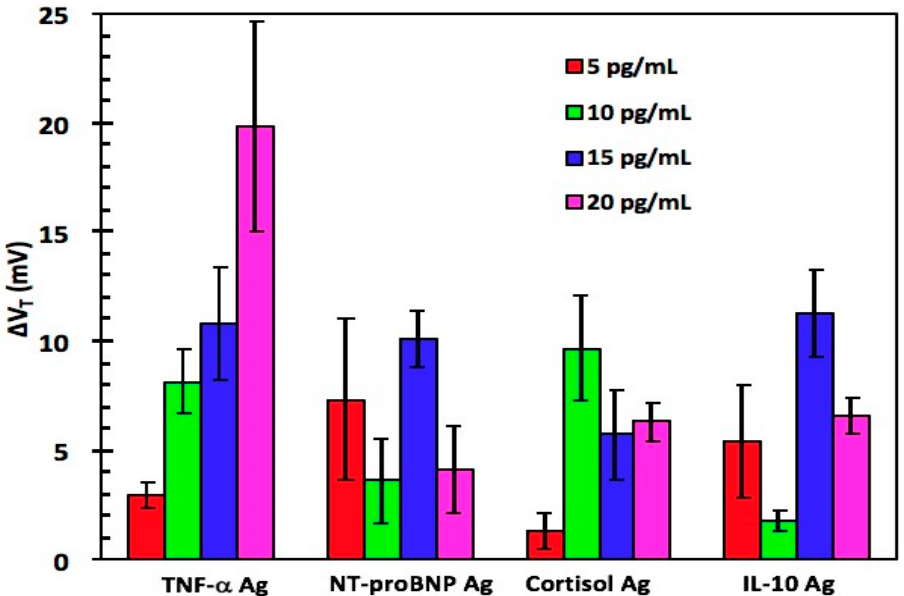
Figure 6. Interference study of Δ V T of ImmunoFET with immobilized anti ‐ mTNF ‐α for TNF ‐α , NT ‐ proBNP, cortisol, and IL ‐ 10 detection.